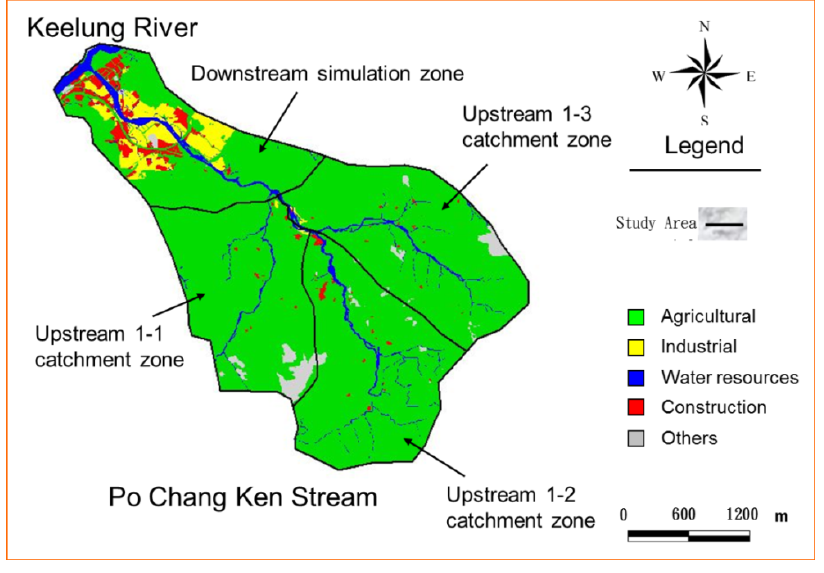
Figure 2. The land use map of the catchments area of the Po Cheng Keng Stream in the Keelung River